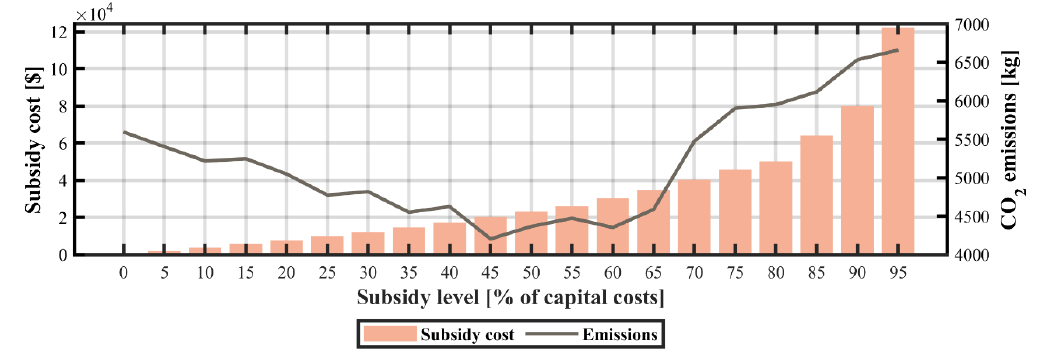
Figure 10. Simulation results of capital subsidies for renewable energy technologies. Impact on subsidy costs and CO 2 emission levels.